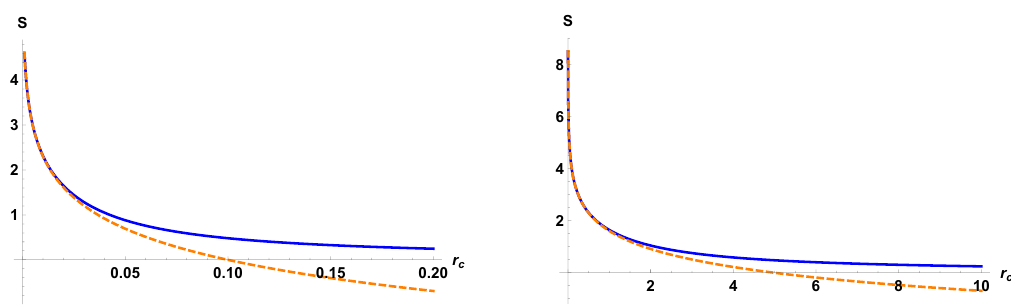
Figure 1 . HEE as a function of r c for d e = 1 and different values of ‘ : Left ) ‘ = 0 . 1 Right ) ‘ = 5 . The solid blue curves show the HEE for the finite cutoff case given in eq. (3.13) and the dashed orange curves indicate the HEE for the zero cutoff case given in eq. (3.7) which are valid for very small cutoffs, i.e. r . Here we set R = 1 and renormalized S as ˜ S = S c (cid:28) ‘